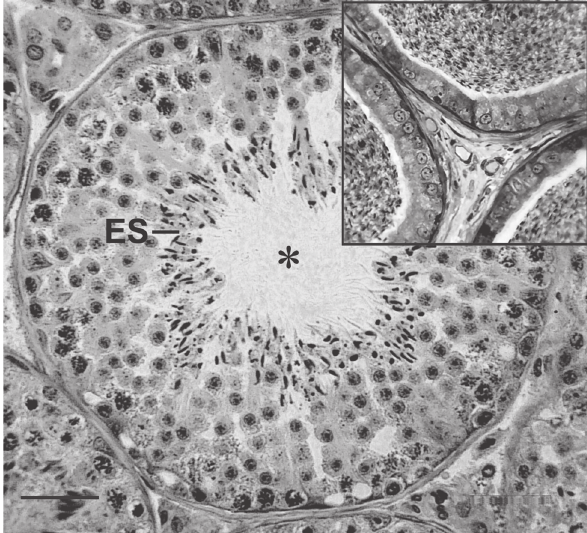
Figure 1. Transverse section of seminiferous tubule of A. lituratus in activity (diameter, 194 ± 8 µm). Note elongated spermatids (ES) and abundant spermatozoa in the lumen (*). Insert shows transverse section of cauda epididymis packed with